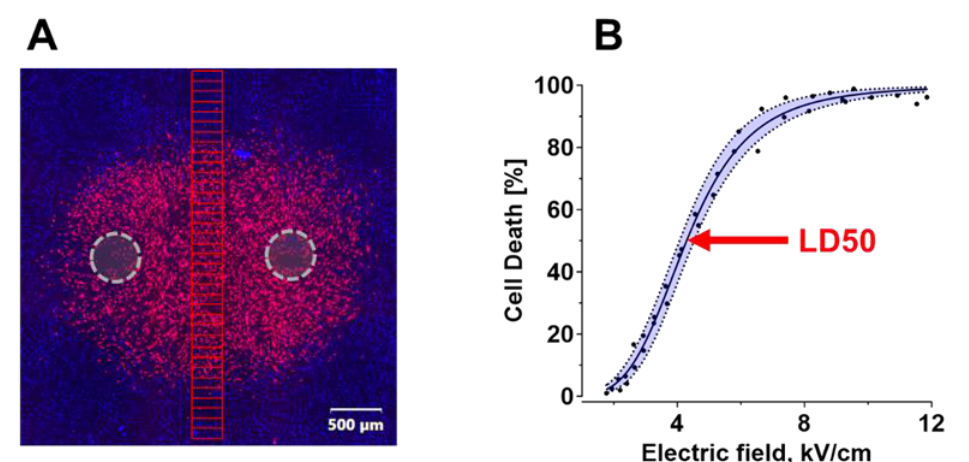
Figure 7. Calculation of LD50 from the fluorescent staining of a monolayer after PEF exposure. ( A ) A representative image of SMC monolayer labeled with Pr (red, dead cells) and Hoechst (blue, all cells; Hoechst staining in dead cells may be concealed by Pr). The monolayer was stained 2 h after applying 100, 600 ns pulses at 10 Hz between two electrodes (gray dashed line circles). Live and dead cells were counted in 36 ROI (red rectangles). ( B ) The percentage of dead cells in each ROI was plotted against the electric field in the center of the ROI and fitted using the Hill equation (solid black line); shaded area is a 95% confidence interval of the fit. Black dots are the mean cell death values from nine independent experiments.